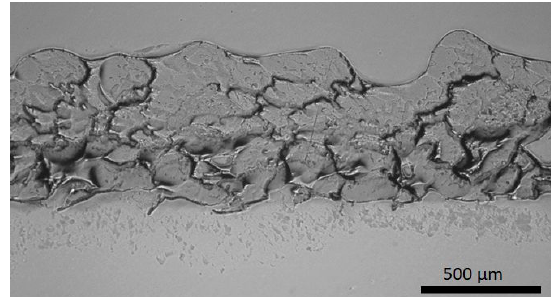
Figure 5. Structure of the FS porous polymer PE coating. Cross-section. OM image.